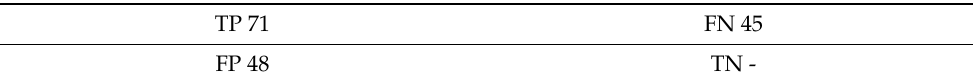
Table 2. Confusion matrix for WTG 109 (TP = True Positive, FP = False Positive, TN = True Negative, FN = False Negative; “-” refers to “none”).